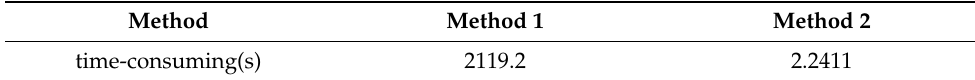
Table 6. Time-consuming comparison under 0.001 parameter